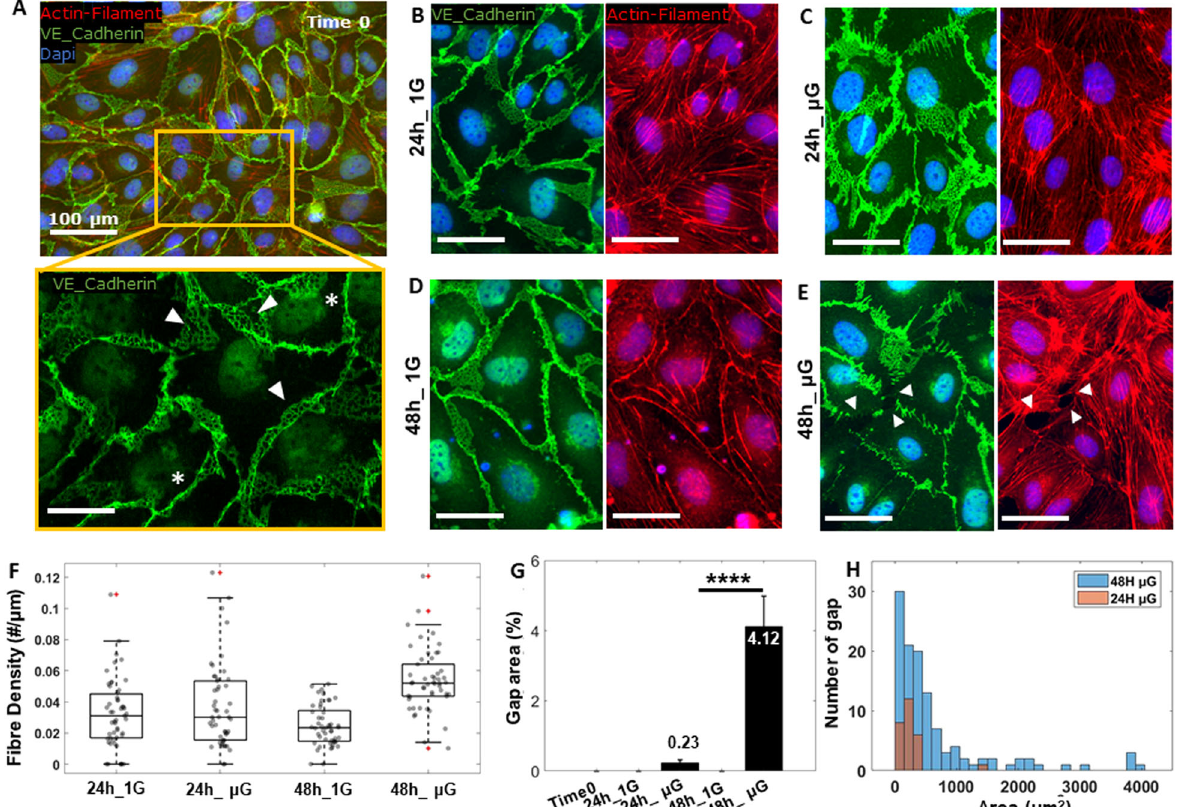
Fig. 7 Junction opening and gap formation. Fluorescence images of a con fl uent monolayer of HUVECs showing Actin-Filament (red), VE-Cad (green) and Dapi (blue) at Time 0 ( A ) and after 24 h and 48 h of gravity (1 G) ( B , D ) and μ G ( C , E ) conditions. Inset of Time 0 shows the heterogeneous patterns of VE-Cad protein clustered at cell border in reticular network (arrows) and linear con fi guration (stars). Intermitted VE- Cad pattern and gap formation in 48 h μ G sample are also indicated with arrows. F Box plots and scatter data points for actin stress fi bers density analyzed for all experimental conditions. G Histogram showing the percentage of opened gap area for all experimental conditions. H Histogram showing the distribution of gap in number and dimension for 24 h and 48 h microgravity group. Scale bars, 50 µm. Asterisks are reported for cases with statistical signi fi cance: **** 24 h μ G Vs 48 h μ G, p = 0.00004. The statistical analysis of the data was performed using one-way analysis of variance (ANOVA) with Turkey ’ s test for multiple